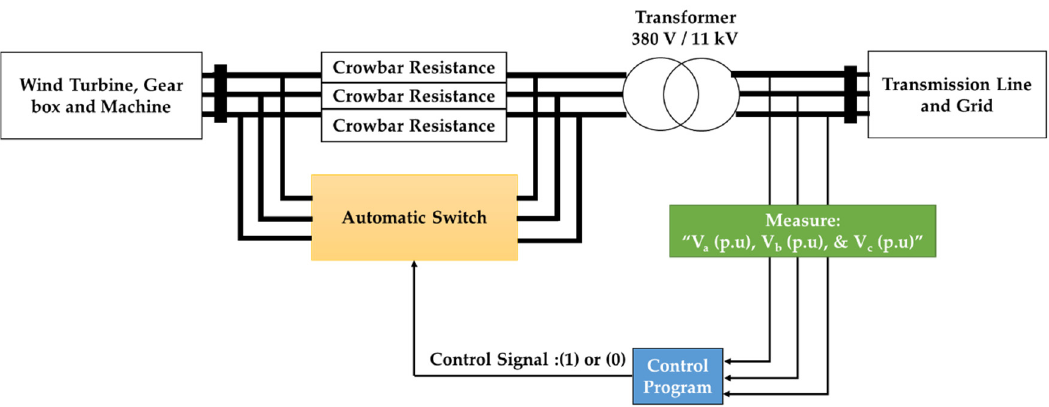
Figure 2. Block diagram of the proposed crowbar technique.